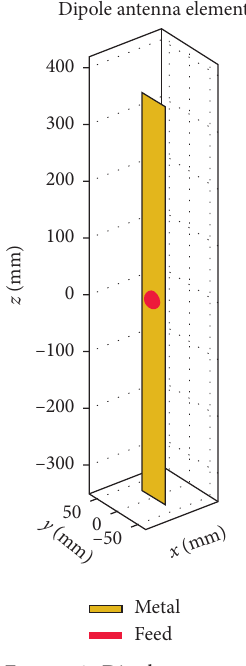
Figure 3: Dipole